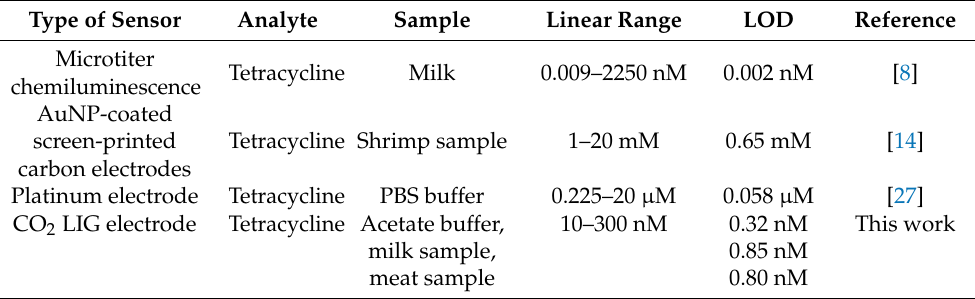
Table 2. Comparison of the LODs of MIP-based different sensors developed so far.